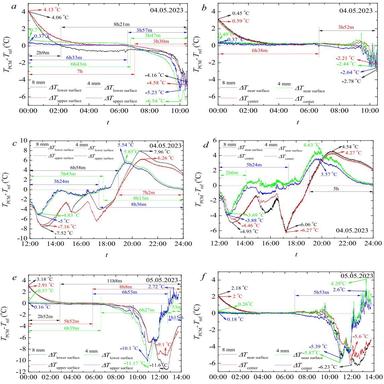
Temperature difference between 3D-SLA/MEPCM-40 board and that of references (3D-SLA/MEPCM-0) for surfaces (a), (c), (e) and temperature difference between the 3D-SLA/MEPCM-40 board and that of references (3D-SLA/MEPCM-0) for room center case (b), (d), (f).